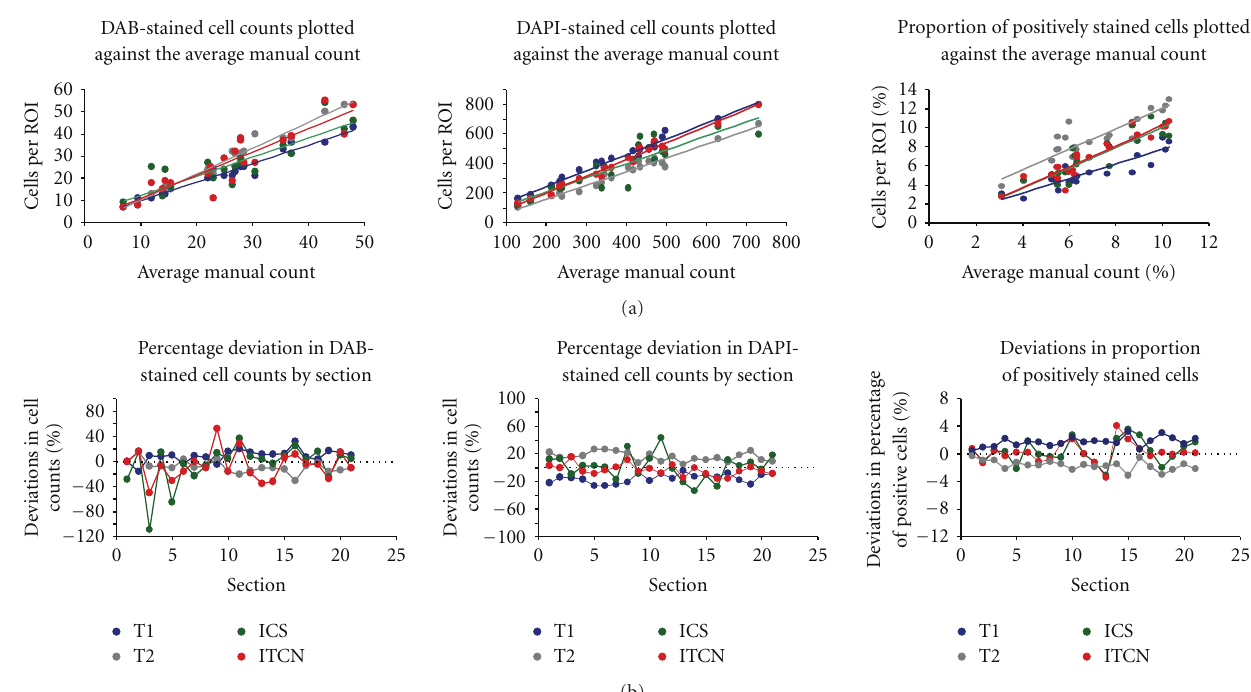
Figure 8: Comparison of automated methods to manual counts. (a) Regressions of the two automated counting methods (ICS and ITCN) and the individual manual cell counts (T1 and T2) against the average of the two manual counts by section. (b) Deviations from the average manual count for the two automated methods and the manual counts by section.